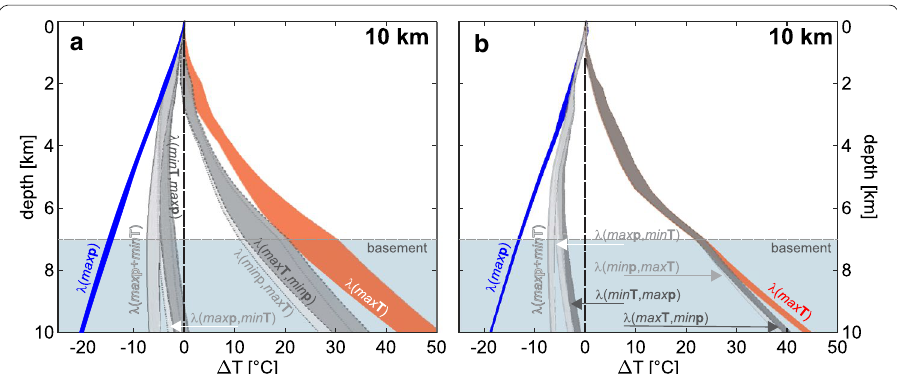
Fig. 4 Temperature difference (Δ T ) plots showing the impact of the different thermal conductivity ( λ ) correction equations on the modeled temperature field for the uppermost 10 km of the upper crust. The bandwidth of the curves show the range of the obtained Δ T in the respective depth level. Several cases for studying the minimum and maximum impact of applying correction functions are considered: only pressure correction of λ [ λ (max p )], only temperature correction of λ [ λ (max T )], and the main rock type‑specific combined minimum and maximum p / T corrections according to Tables 1 and 2. a Magmatic–metamorphic scenario with two ways of p / T corrections for minimum [ λ (max p ,min T ) and λ (min T ,max p )] and maximum [ λ (min p ,max T ) and λ (max T ,min p )] of Δ T , respectively. b Sedimentary scenario with 3 ways of p / T corrections for the minimum case [ λ (max p min T ), λ (max p ,min T ) and λ (min T ,max p )] and two ways of p / T corrections for + the maximum case [ λ (min p ,max T ) and λ (max T ,min p